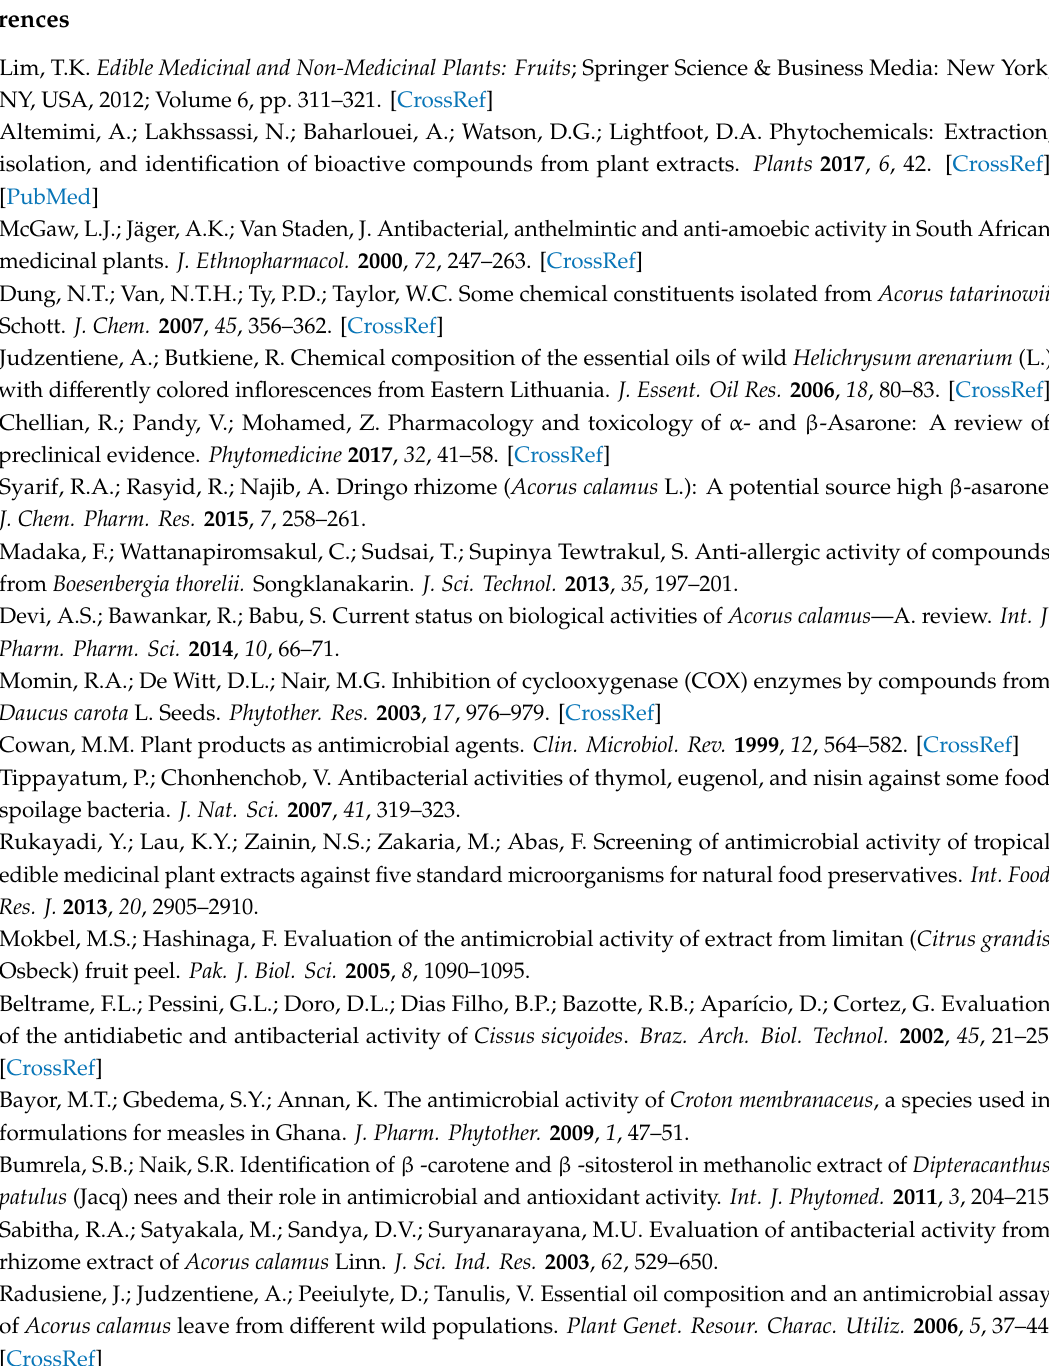
Figure S8: 13 C-NMR spectrum of asaronaldehyde (125 MHz, CDCL3), Figure S9: Selected HSQC correlation spectrum of asaronaldehyde, Figure S10: Selected HMBC correlation spectrum of